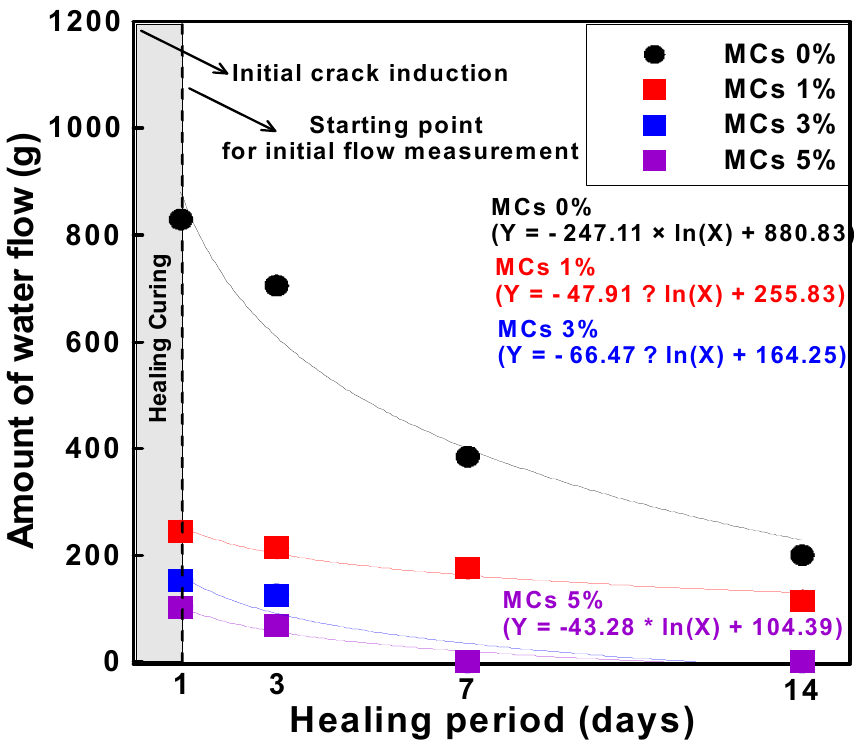
Figure 14. Variation healing rate according to MCs mixing rate (3 to 14 days for 1 day).